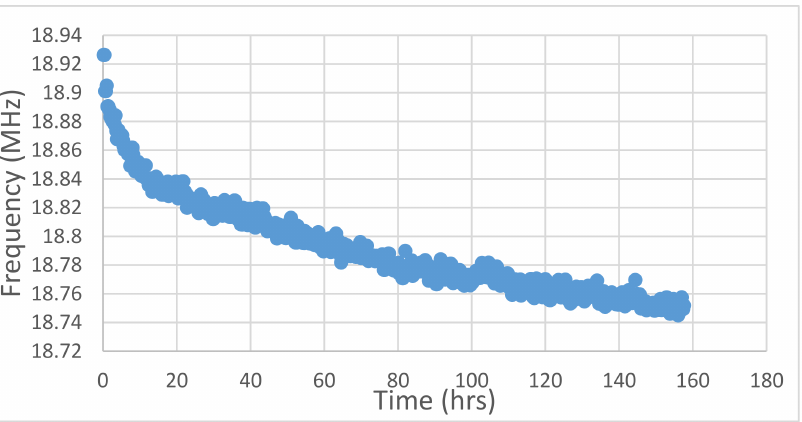
Figure 4. Plot of frequency degradation of a ring oscillator (RO) composed of 101 stages in hours. The data as-is cannot be extrapolated to a time to failure value without being converted to the correct time